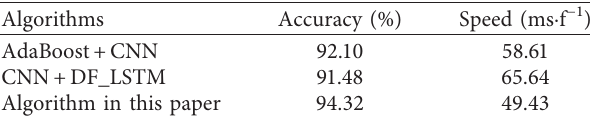
Table 4: Comparison of fatigue detection